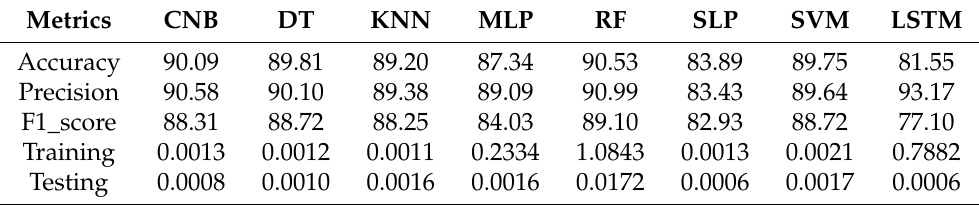
Table 3. Average cross-validation scores of models and their training and testing